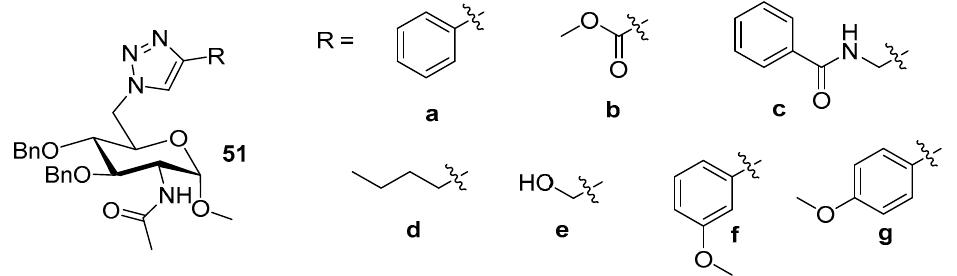
Figure 36 . Triazole linked N-acetylglucosamine-based gelators [82].